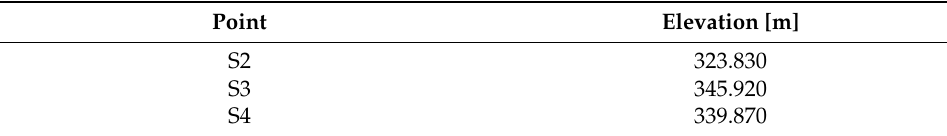
Table A6. Elevations of S2, S3 and